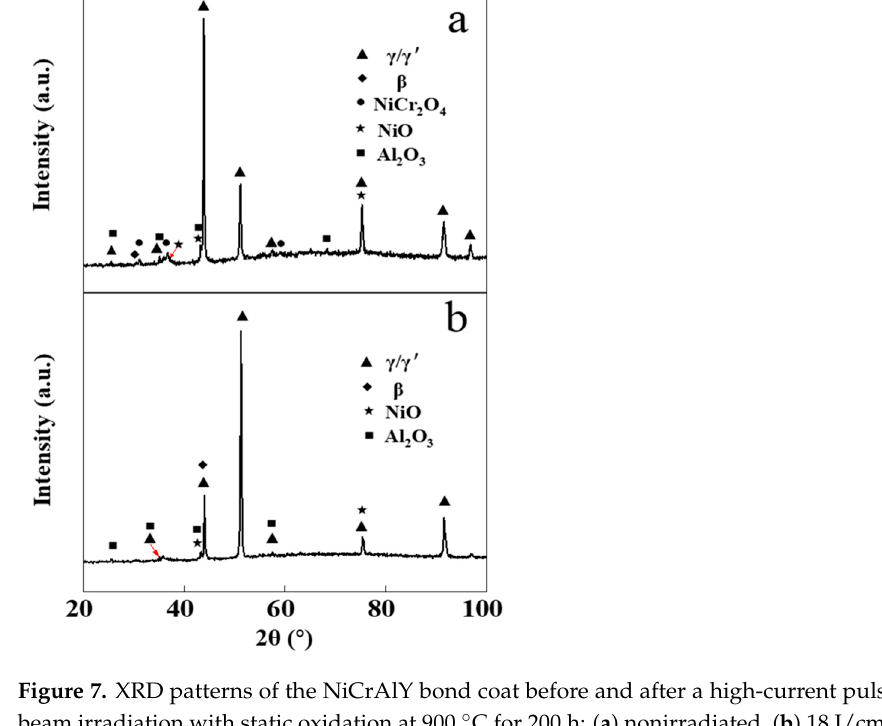
Figure 6. Sectional SEM backscattering images of the NiCrAlY coating before and after a high ‐ cur ‐ rent pulsed electron beam irradiation with static oxidation at 900 °C for 200 h: ( a ) nonirradiated, ( b )